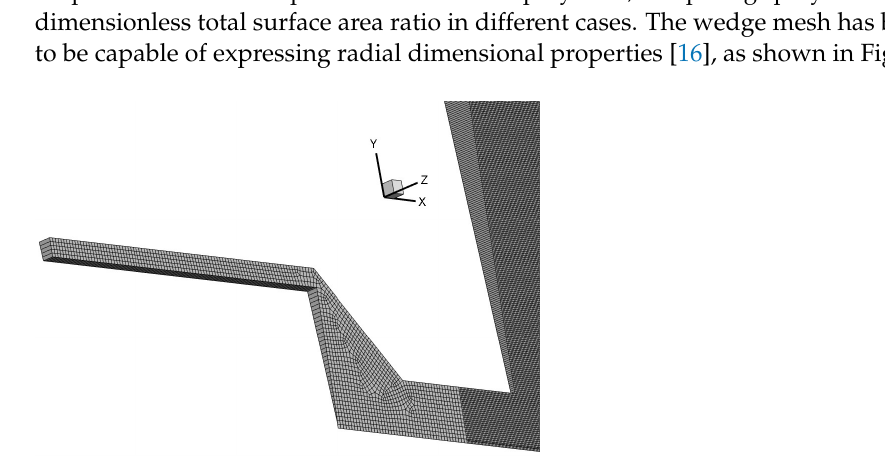
Figure 1. Simulation wedge mesh with 5 degrees to express the flow characteristics.